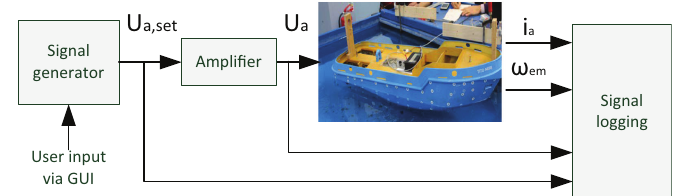
Figure 4. Block diagram of experimental